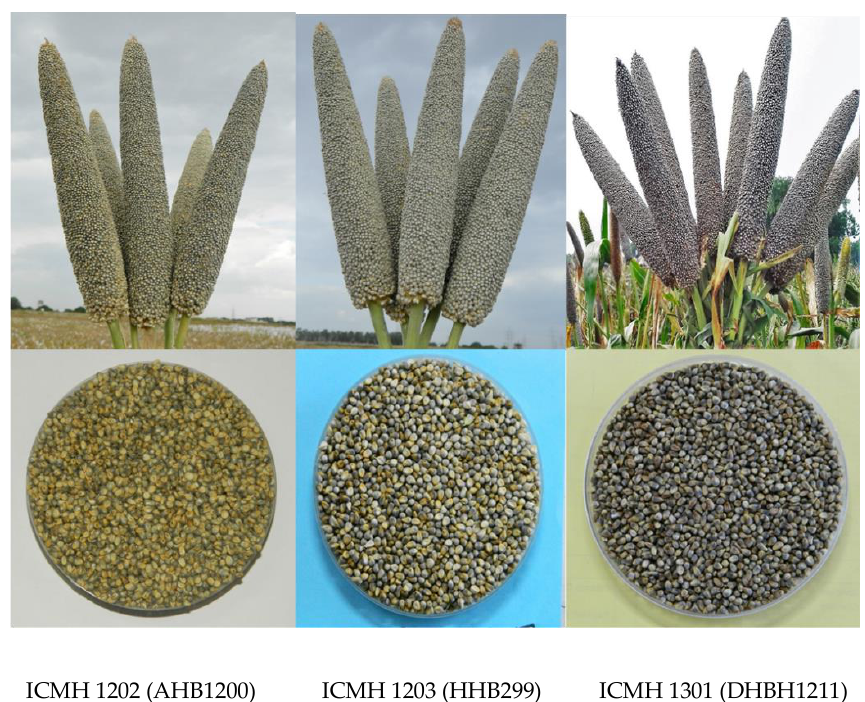
Figure 2. Released and notified biofortified high-yielding hybrids in